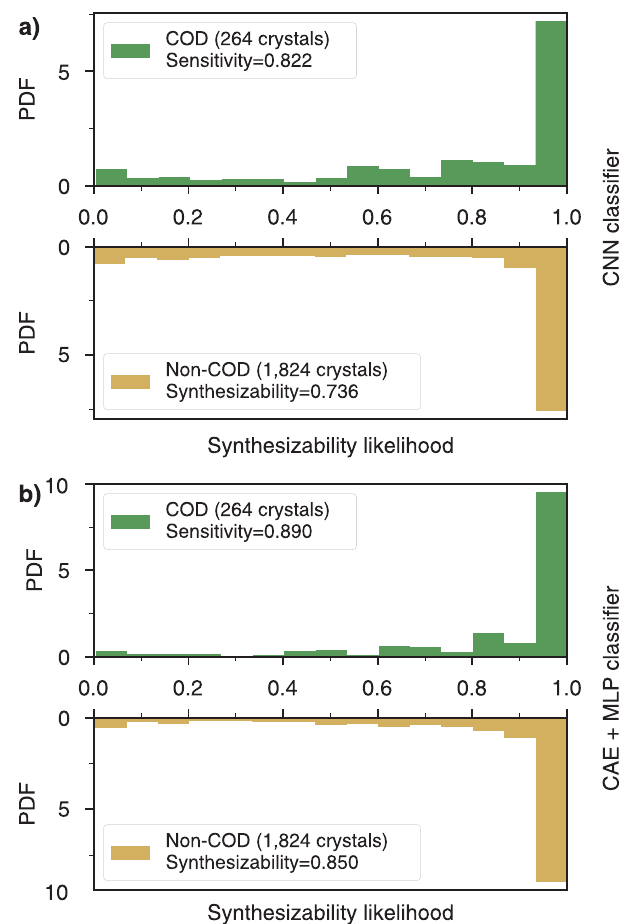
Fig. 4 Synthesizability likelihood predictions of the candidate crystalline materials for electrodes. The probability distribution function of the 2088 electrode crystals from the Battery Explorer database of the Materials Project (MP) is predicted by ( a ) the CNN and ( b ) the CAE + MLP classi fi ers, respectively. The green and yellow bars show the samples from the COD and those absent in the COD, respectively. Synthesizability refers to the ratio of predicted synthesizable samples to the crystal samples in the non- COD electrode data. The sensitivity (or recall) is calculated based on the 264 electrode samples that belong to the identify the best materials, where the ideal candidates lie near the top right on the charts in this case. The top right region in Fig. 5a corresponds to a high volumetric capacity combined with a high likelihood of synthesizability. Similarly, the top right region in Fig. 5b corresponds to a high voltage combined with a high likelihood of synthesizability. For more synthesizability predic- tions for electrode materials, refer to Supplementary Fig. 11, Supplementary Table 3, and Supplementary Note 10.